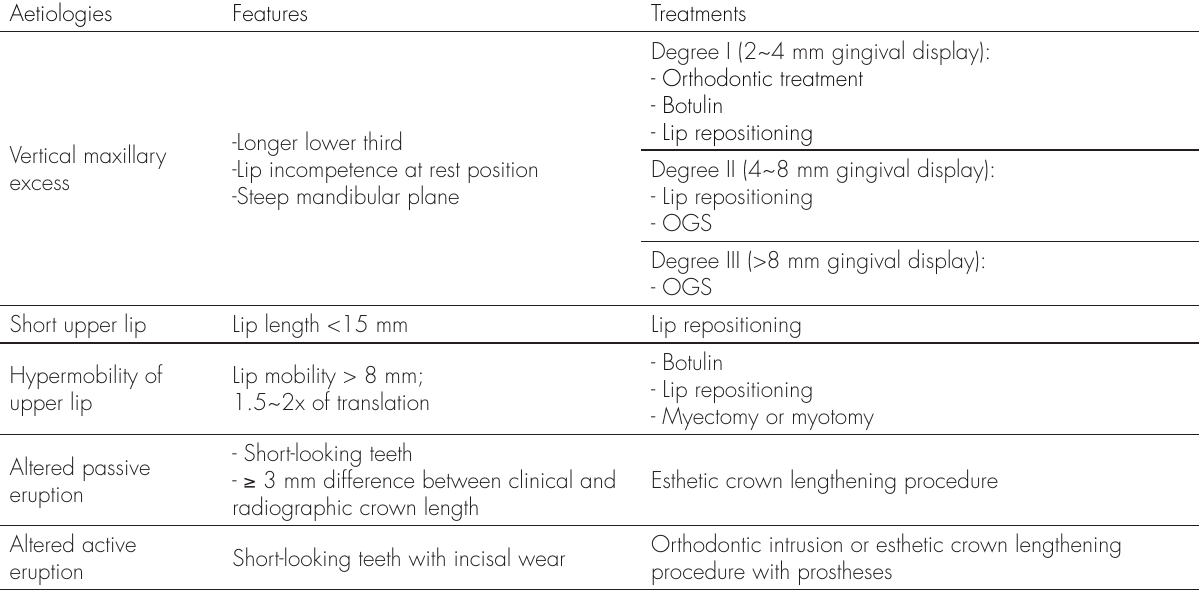
The length of upper lip: the distance between the subnasale to the lower border of the upper lip Lip mobility = Upper lip length at rest – upper lip length at full